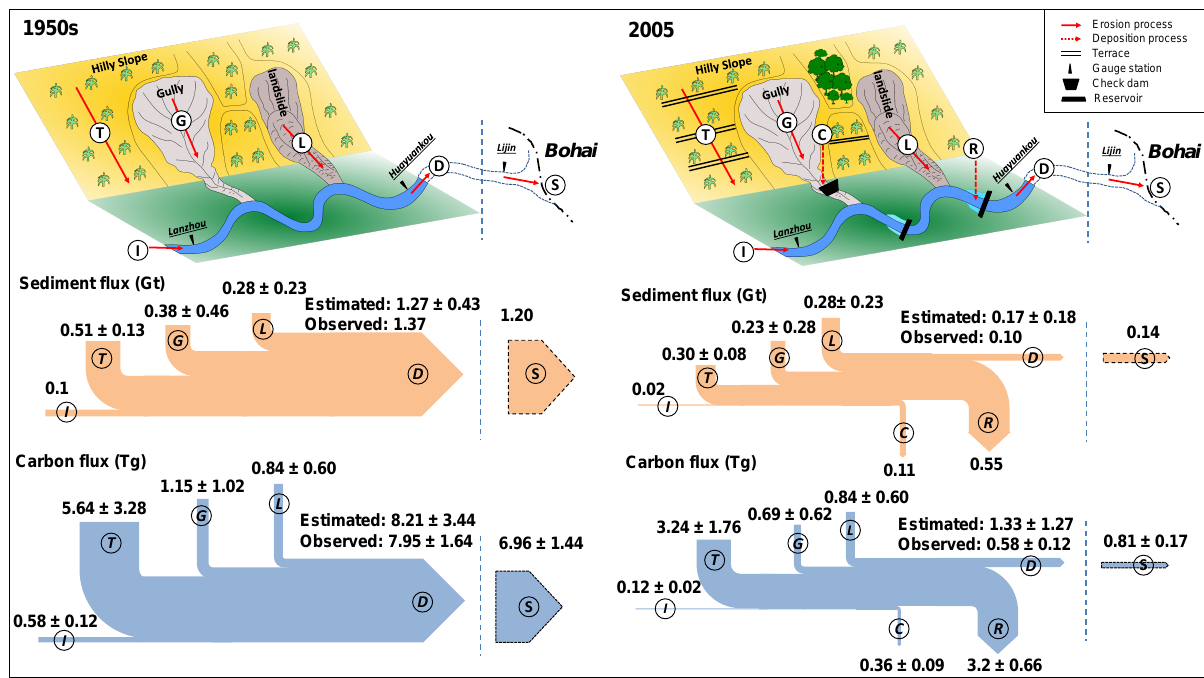
Figure 9. Sediment and carbon budget for the CLP in 1950 and 2005. Sediment input from upstream was the average sediment discharge observed at Lanzhou station (Fig. 1). Sediment export from the CLP was the average sediment discharge observed at Huayuankou . Sediment delivery to the Bohai sea is the averaged sediment discharge observed at Lijin . Characters with a circle represent different erosion and/or deposition processes: I : input from upstream; T: topsoil erosion; G: gully erosion; L: landslides; C: deposition behind check dam; R: deposition in reservoirs; D: sediment/carbon export from CLP; S: delivery to Bohai